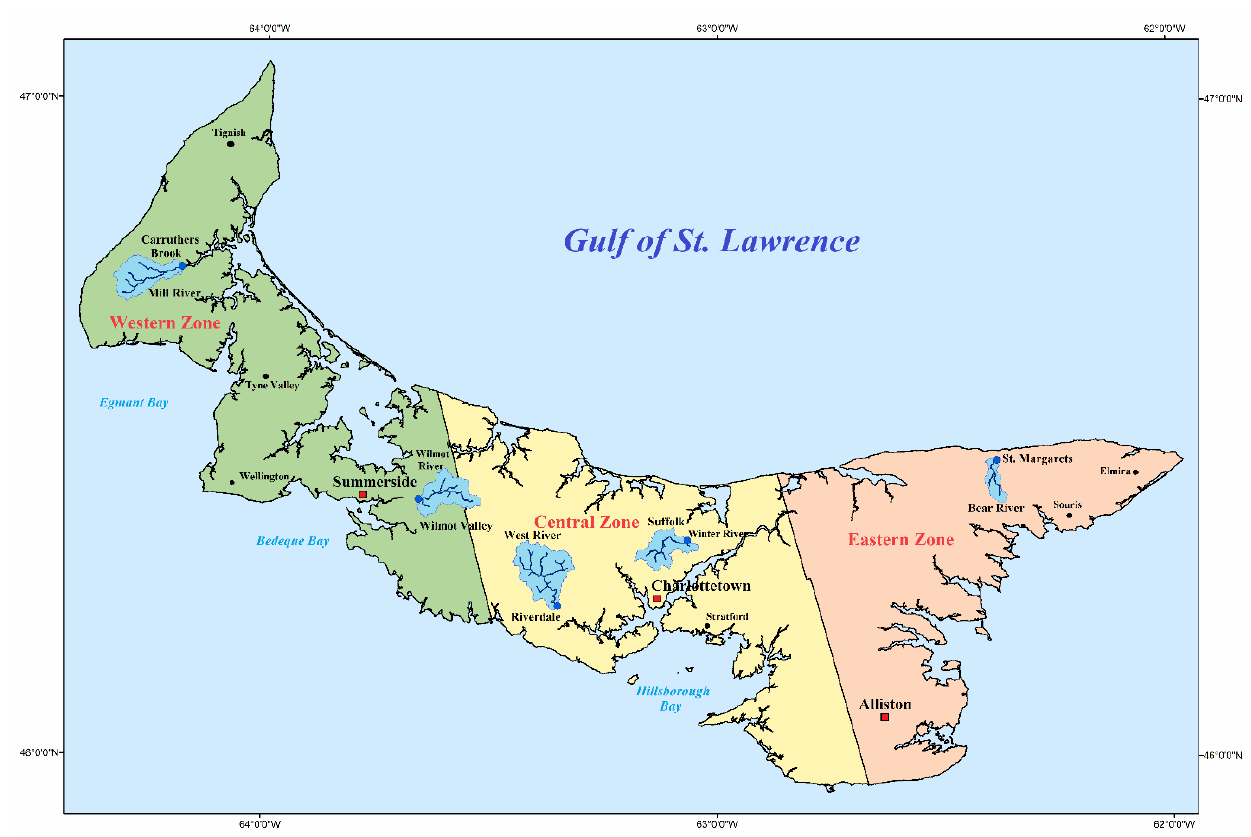
Figure 1. PEI climatic zones, weather stations , and modeled watersheds .